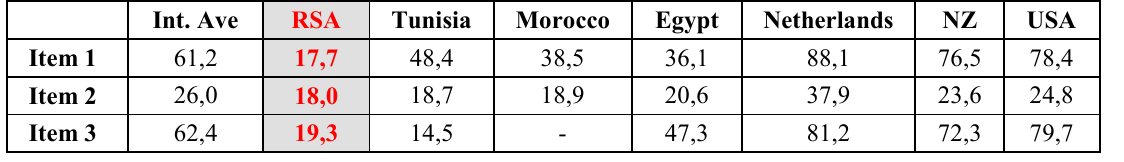
Figure 1: Items from TIMSS (Source: TIMSS,